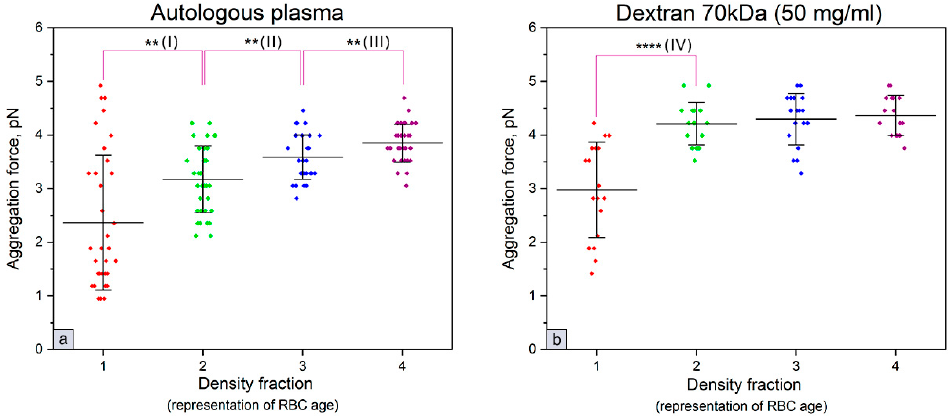
Figure 4. The dependence of the AF on the cells’ age (the higher the layer number the older the cells) for ( a ) RBCs in autologous plasma and ( b ) RBCs in the dextran 70 kDa solution at the concentration 50 mg / mL. Data from 5 healthy volunteers are presented. Bars here represent standard deviations. (I) p = 0.003, (II) p = 0.002, (III) p = 0.004, (IV) p = 2 × 10 − 5 .